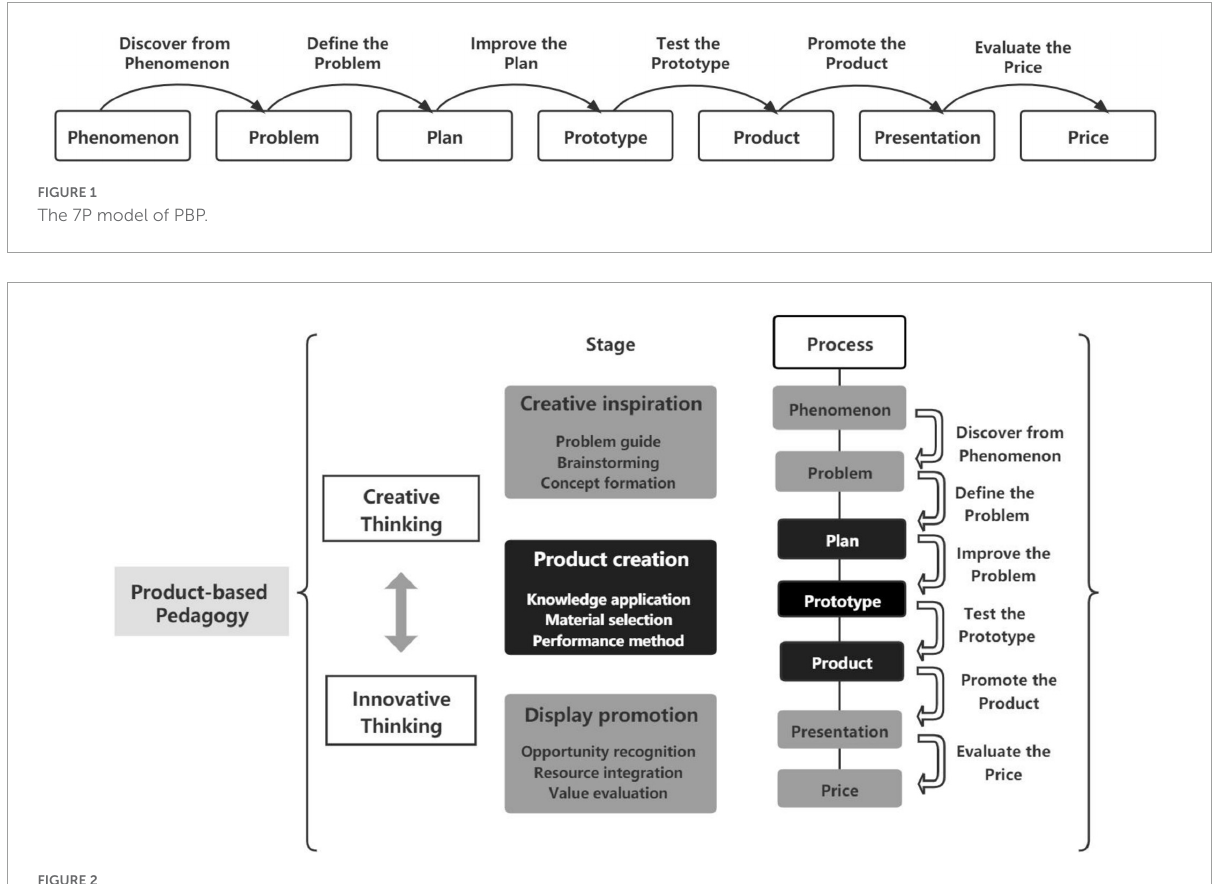
FIGURE2 PBP in high-school AI